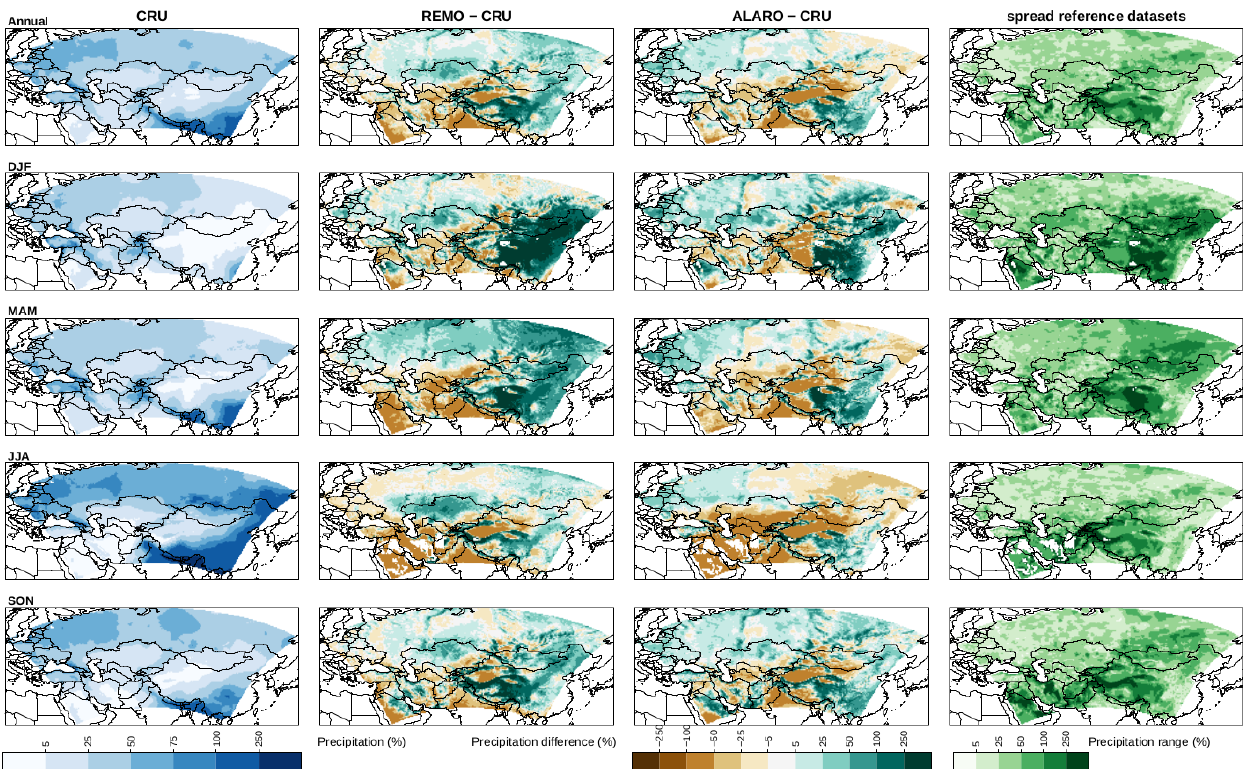
Figure 10. Left column: mean monthly precipitation amounts (mm per month) over the CAS-CORDEX domain based on the observational CRU dataset for the 1980–2017 period on an annual level and for winter (DJF), spring (MAM), summer (JJA), and autumn (SON). Middle columns: relative difference between the average annual and seasonal CRU precipitation and the precipitation simulated by the models (%). Right column: the range in precipitation (%) between the different reference datasets (CRU, MW, GPCC, and